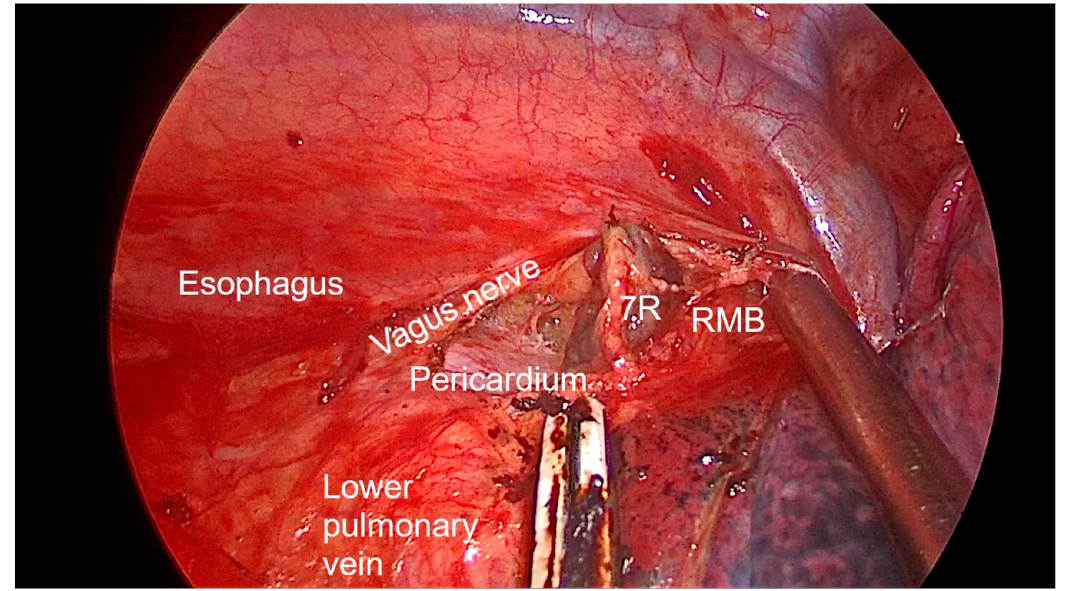
Figure 6. Anatomic landmarks during right subcarinal lymph node dissection (7R). RMB—right main bronchus.